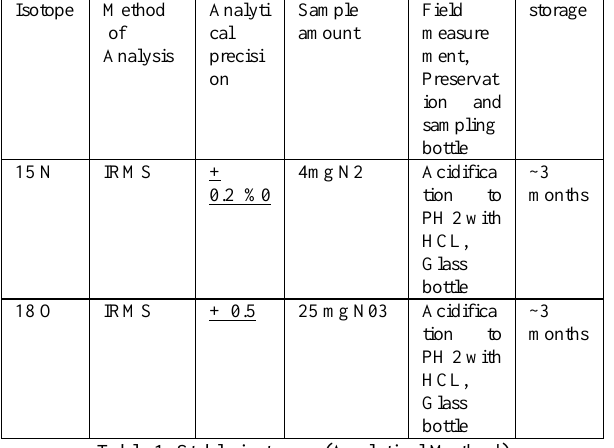
Table 1. Stable isotopes, (Analytical Method)